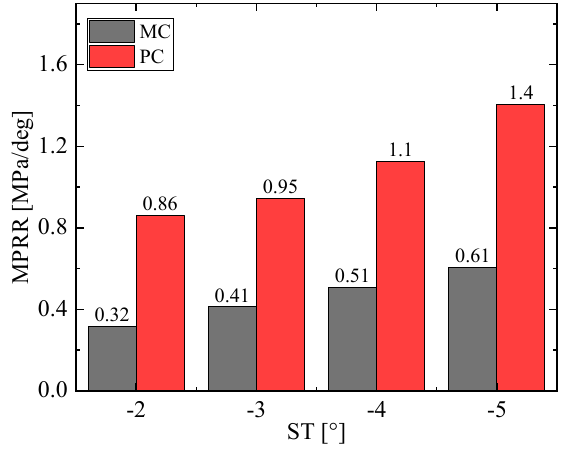
Figure 16. Predicted MPRR for PCFR = 0%, CR = 13, and λ = 4 using different STs.